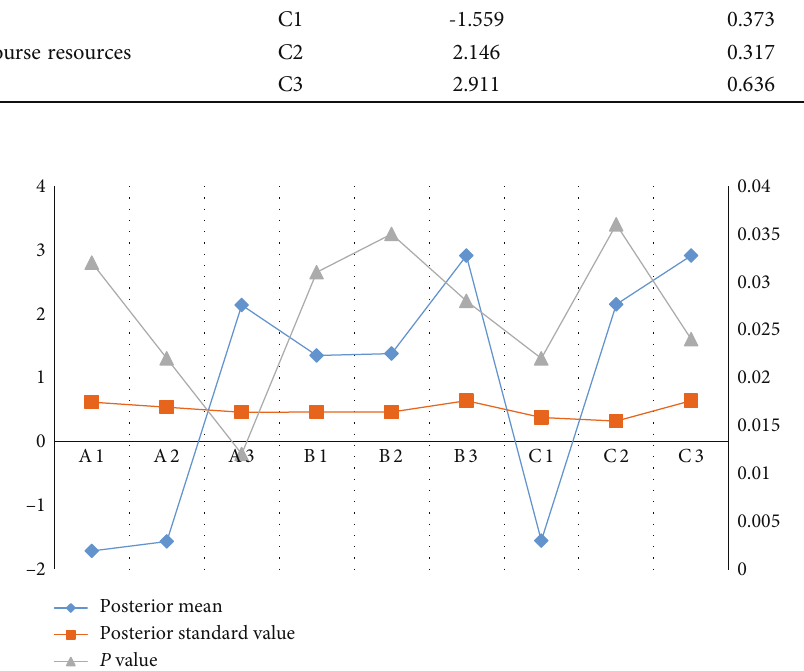
Figure 10: Factor parameter estimation results.